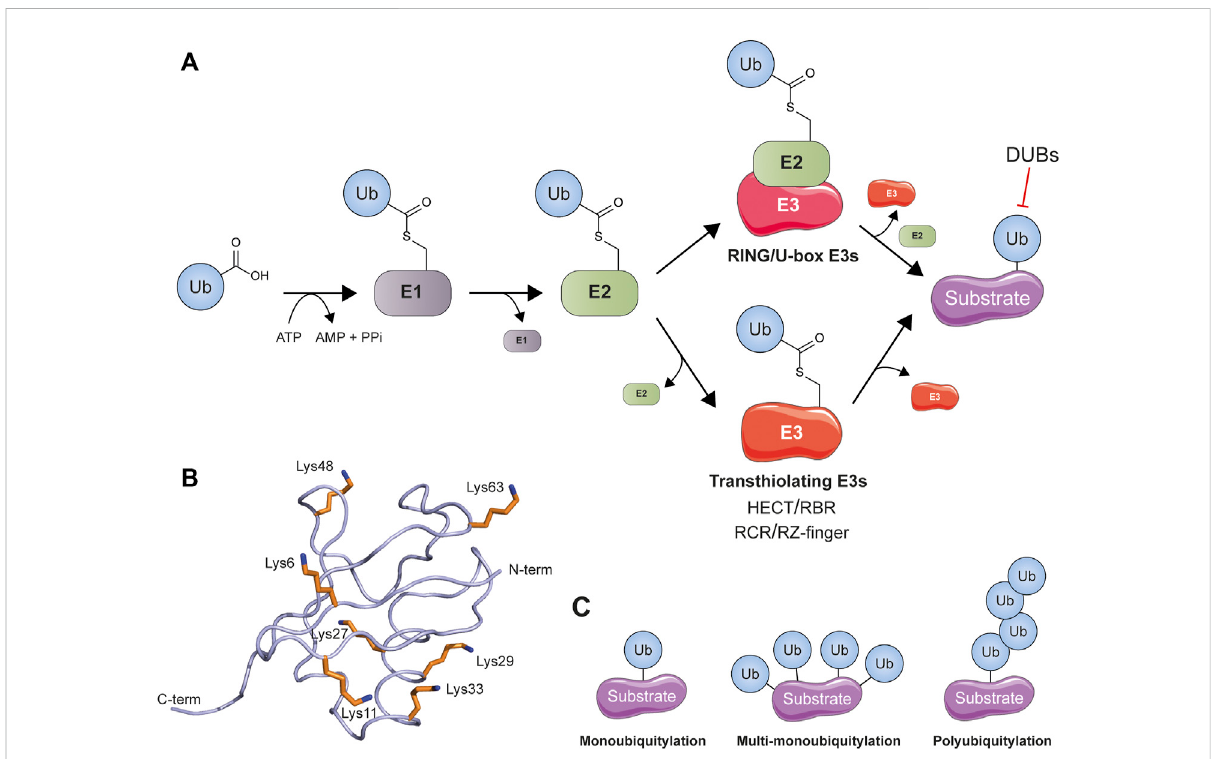
Components of the conventional ubiquitylation cascade. (A) A multicomponent enzyme cascade is used to transfer ubiquitin (Ub) to its substrates. RING and U-box ligases facilitate the transfer of ubiquitin from E2 directly to substrate lysine whereas the transthiolating classes of ligase (HECT/RBR/RCR/RZ- fi nger) fi rst covalently bind ubiquitin at their own active site cysteine before transferring it to substrate. Ubiquitin can be removed by specialized deubiquitylating enzymes (DUBs). (B) The structure of ubiquitin (PDB: 1UBQ) (Vijay-Kumar et al., 1987) is shown as a smoothed backbone trace. The position of ubiquitin ’ s seven lysine residues is indicated. (C) Different ubiquitylation topologies are possible: monoubiquitylation, multi-monoubiquitylation, and polyubiquitylation (in which ubiquitin can ubiquitylate itself to form amide-linked chains) all